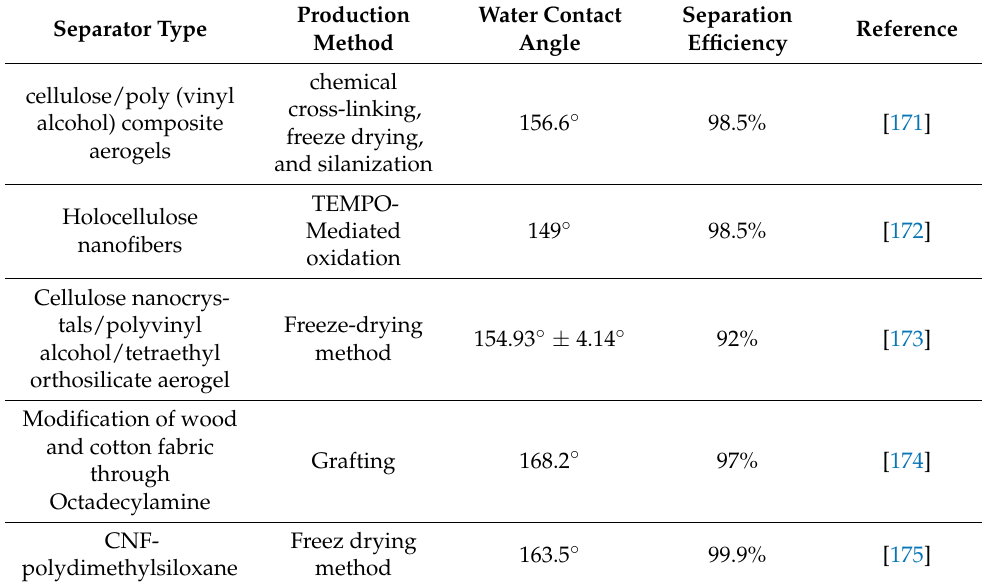
Table 5. Oil-water separation through superhydrophobic nanocellulose-based